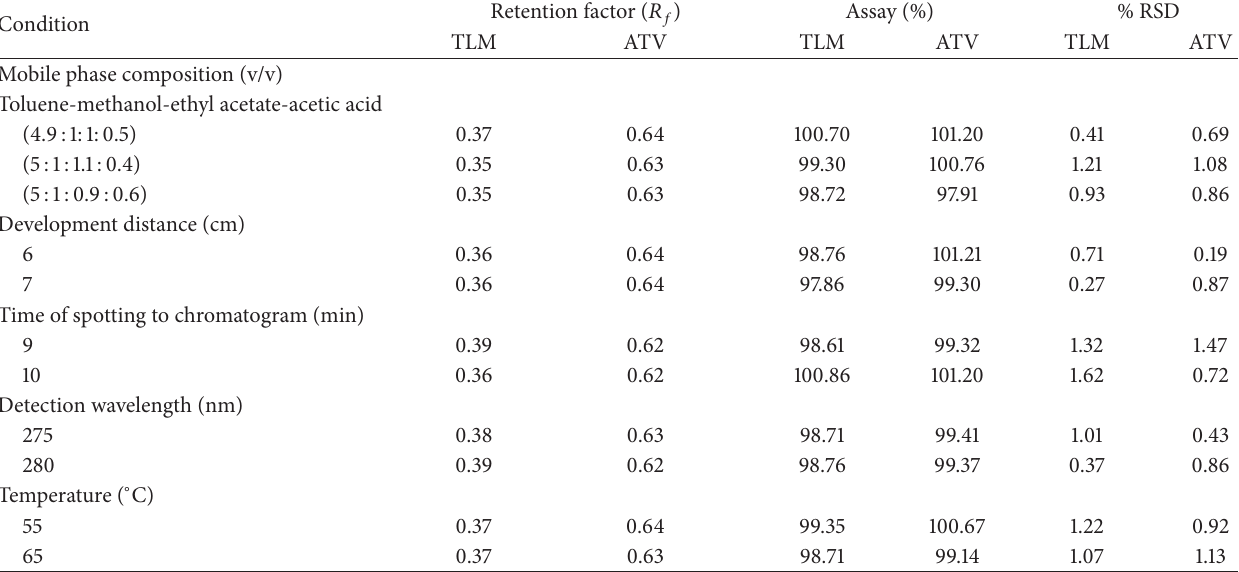
Table 7: Results of robustness study by